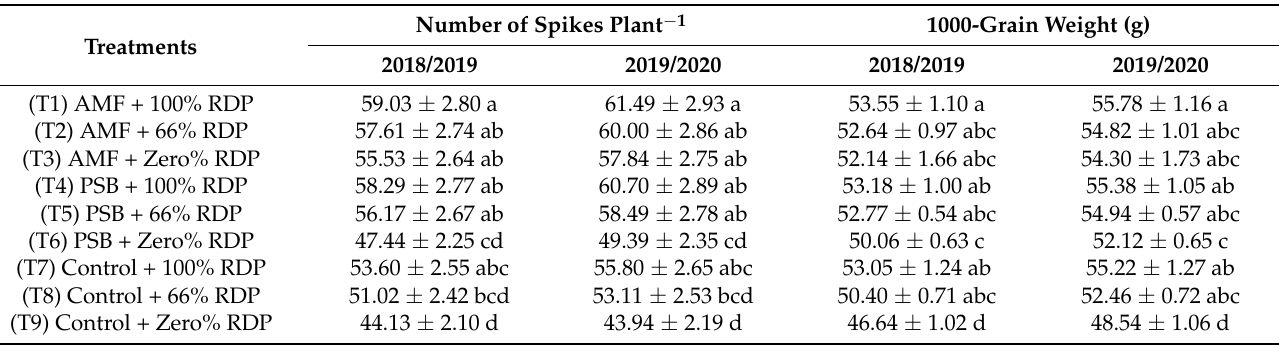
The values are the mean values ± standard error values. Different letters next to the values indicate significant differences at p ≤ 0.05 according to Duncan’s multiple range test. Table 4. Number of spikes per plant and 1000-grain weight of Giza 123 barley cultivar were affected by treatment with arbuscular mycorrhizal fungi (AMF), phosphate-solubilizing bacteria (PSB), and different percentages of the recommended dose of phosphorus fertilizers (RDP) in the 2018/2019 and